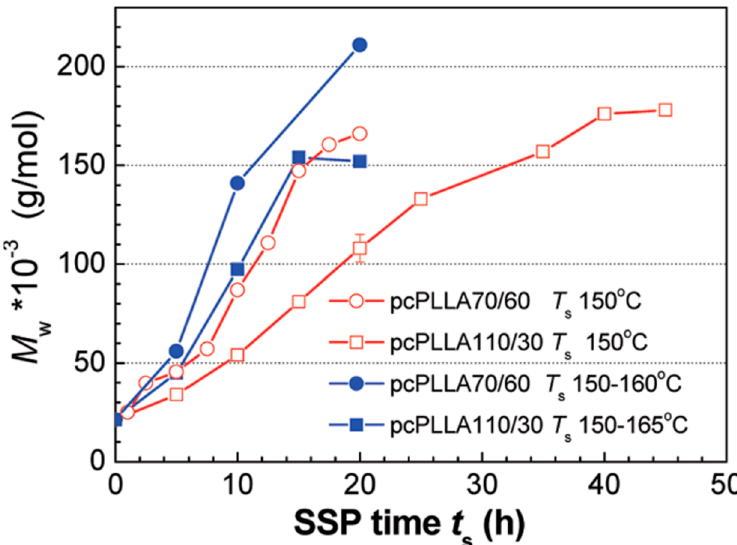
Figure 3. MW growth during SSP at constant and step-raised temperatures for pcPLLA70/60 and pcPLLA110/30, respectively: ( ○ ) 70 °C/60 min + 150 °C/20 h; ( □ ) 110 °C/30 min + 150 °C/40 h; ( ● ) 70 °C/60 min + 150 °C/5 h + 155 °C/5 h + 160 °C/10 h; ( ■ ) 110 °C/30 min + 150 °C/5 h + 155 °C/5 h + 160 °C/5 h + 165 °C/5 h. [90].